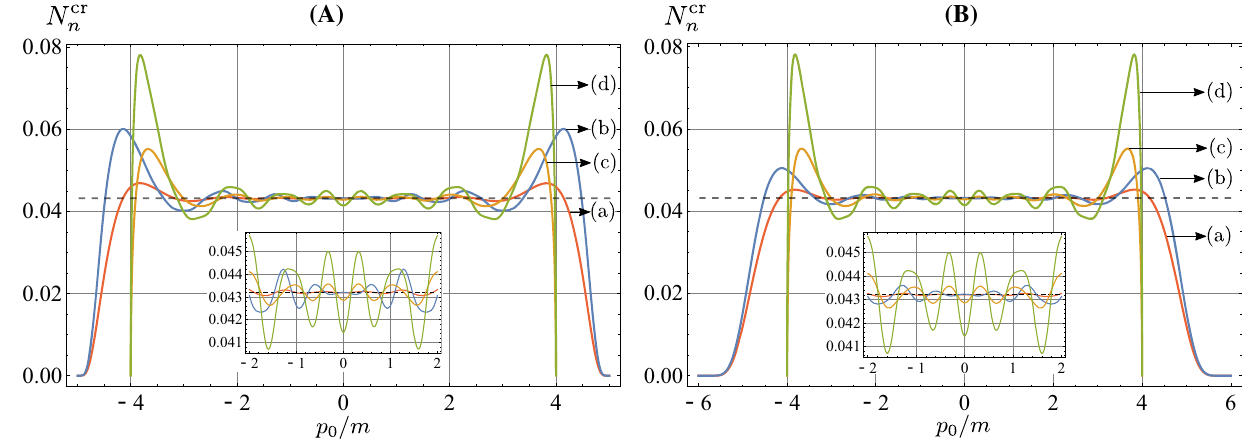
Fig. 9 Differential mean numbers N cr n of particles created from the vacuum by the composite electric field (106) [solid lines (a, b)] and by the L -constant electric field (105) [solid lines (c, d)], with field ampli- tudes E = E c and fixed length scale mL = 10. In the left panel ( A ), m ξ 1 = m ξ 2 = 1, while in the right panel ( B ), m ξ 1 = m ξ 2 = 2.